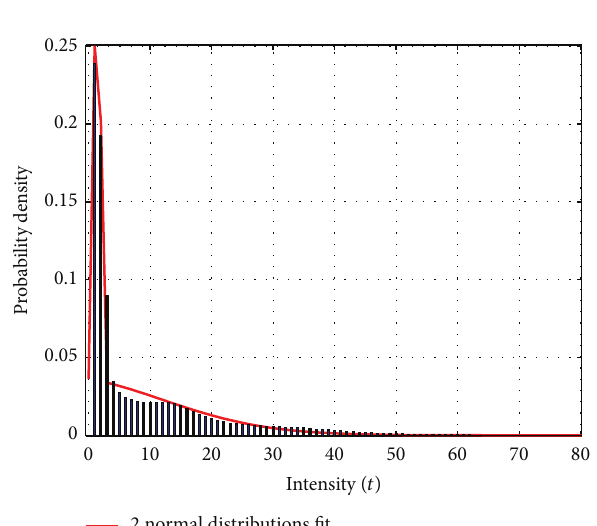
Figure 5: One normal distribution fitted.